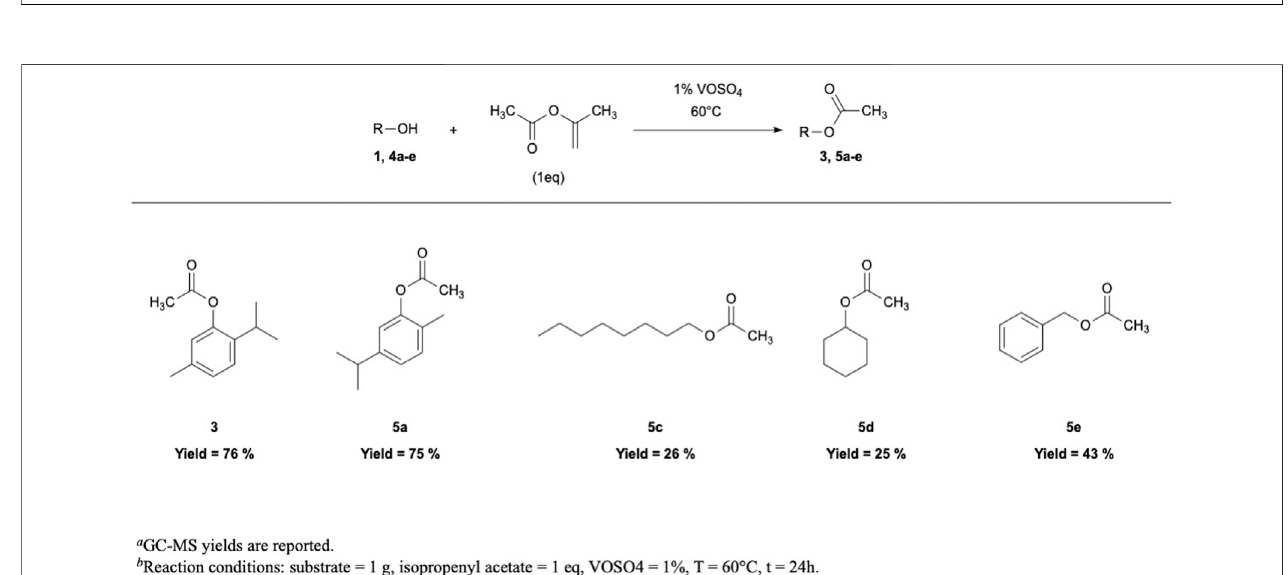
FIGURE 3 | O -acetylation with isopropenyl acetate.